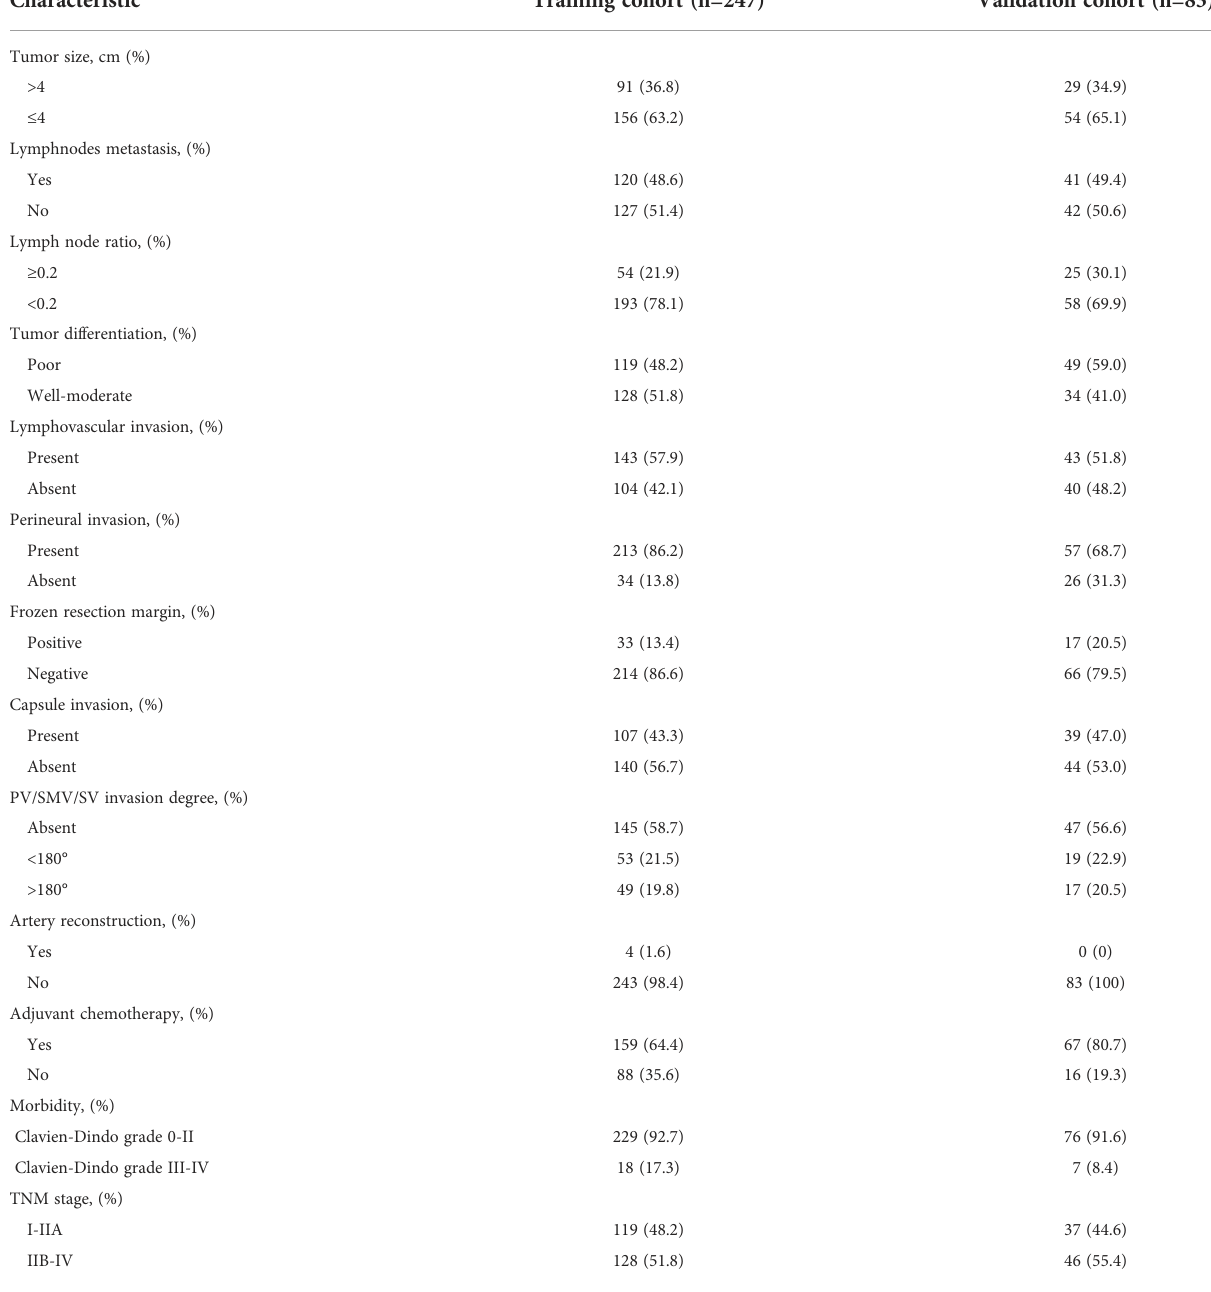
(Figure 3). The C-indexes of nomogram based on the training and validation cohorts were 0.760 (95% con fi dence interval [CI], 0.720-0.799) and 0.739 (95% CI, 0.669-0.810), respectively. The AUC of the nomogram at 1-, 2- and 3-year was 0.815, 0.803 and 0.773 in the training cohort, and 0.765, 0.879 and 0.908 in the validation cohort, respectively, all of which were higher than AJCC and JPS of TNM stage system (Figure 4 and Table